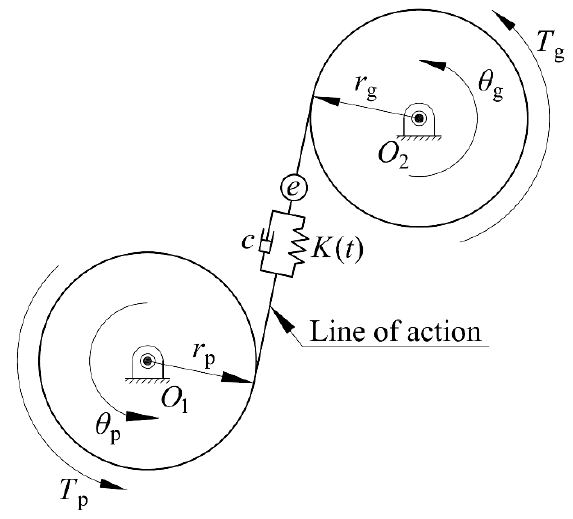
Figure 6. Dynamic model of a spur gear pair.